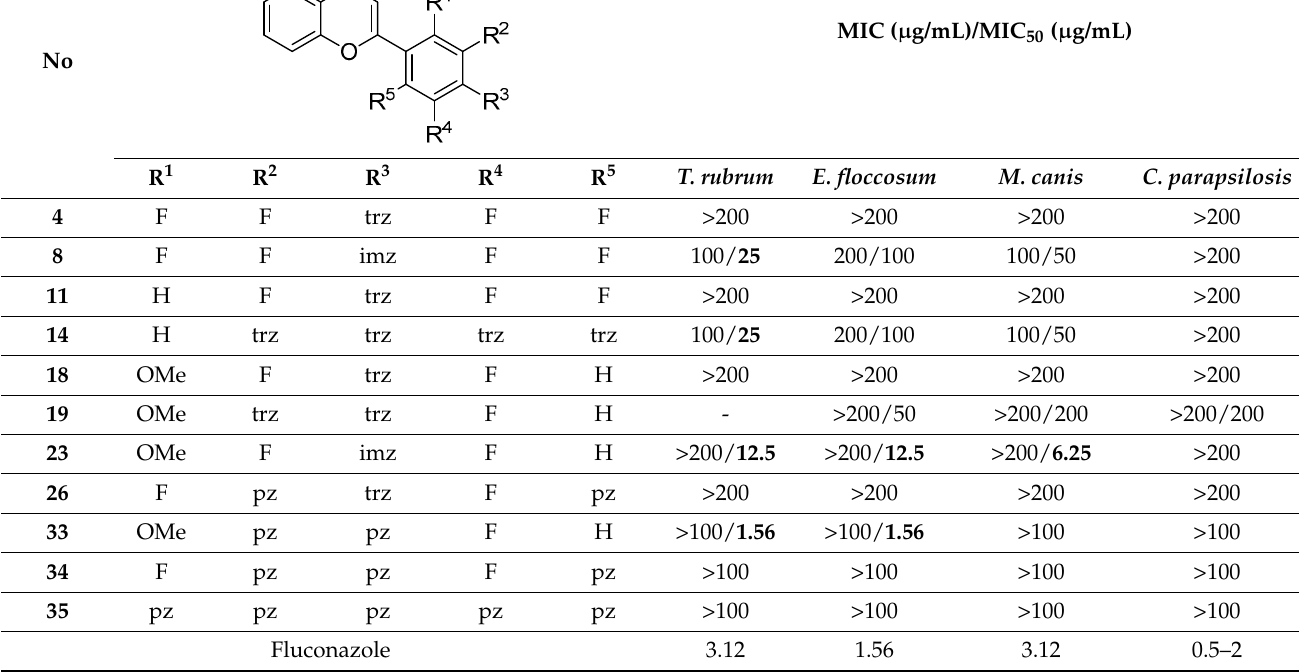
Table A3. Fungistatic activity of fluorinated flavones and their azolyl-substituted derivatives. Compounds